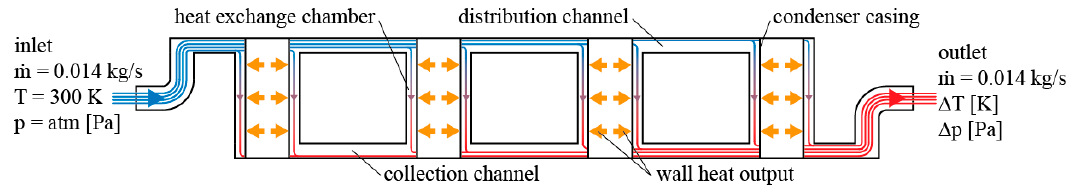
Figure 3. Boundary conditions of the computational fluid dynamics (CFD simulation with a depicted representation of flow trajectories.